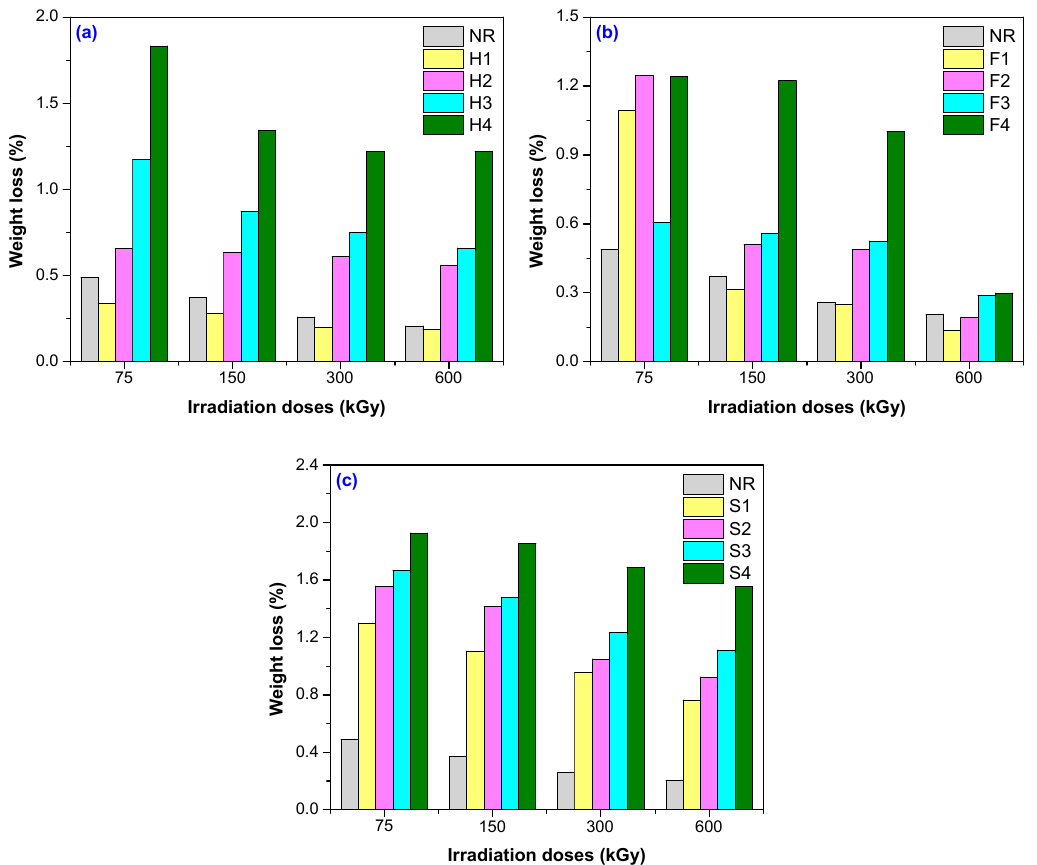
Figure 4. Weight loss variation for NR samples reinforced with hemp ( a ), flax ( b ) , and sawdust ( c ) .